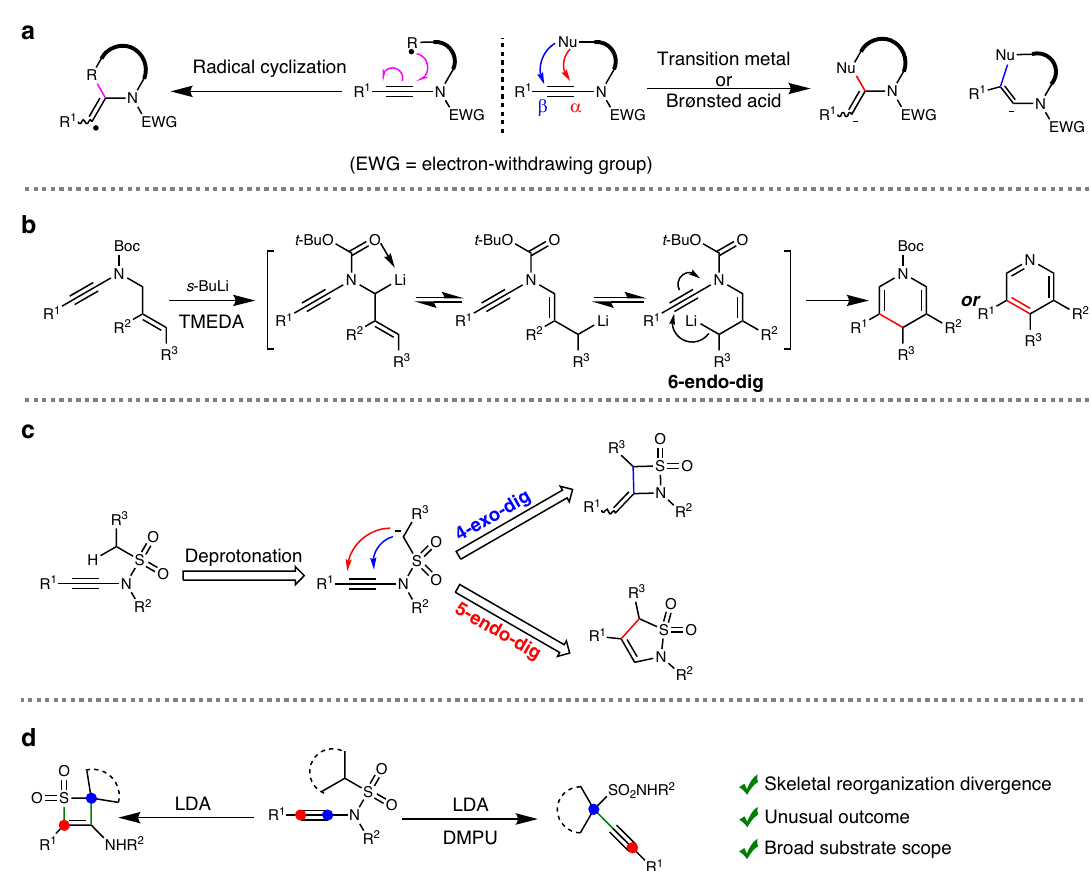
Fig. 3 Skeletal reorganization of ynamides. a Intramolecular cyclizations of ynamides. b Skeletal reorganization of N -Boc ynamides. c Our initial hypothesis. d This work: Skeletal reorganization divergence of N -sulfonyl